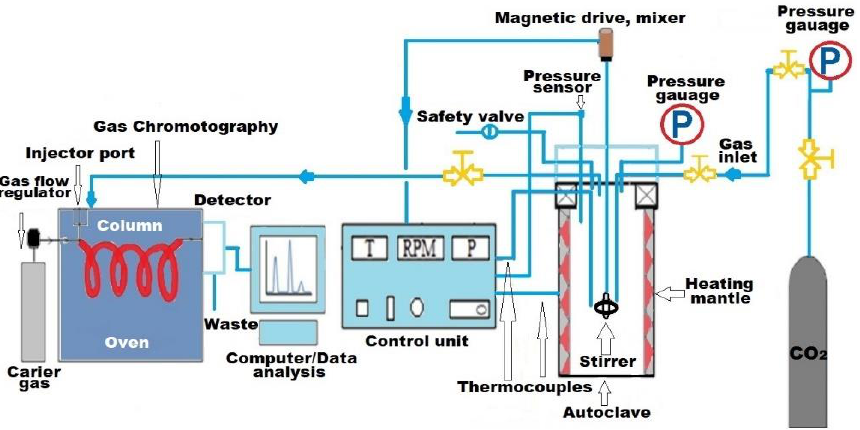
Figure 14. The schematic illustration of High Pressure-High Temperature